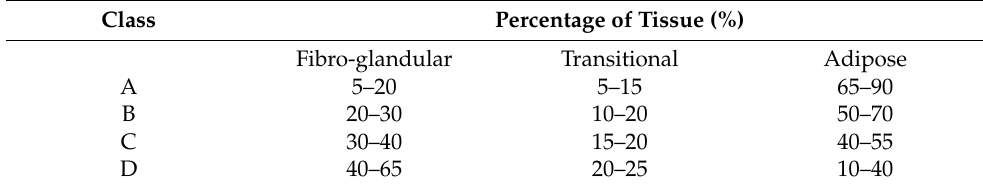
Figure 2. Overview of the realistic numerical breast phantom generation procedure. ( a ) Elliptical- shape phantom generation with corresponding skin layer. ( b ) Internal-tissue spatial distribution via a random field generator [77] and ( c ) estimated electromagnetic (i.e., relative permittivity and conductivity) tissues assignment (for the sake of brevity, only the relative permittivity is reported). Table 2. Breast phantom tissues